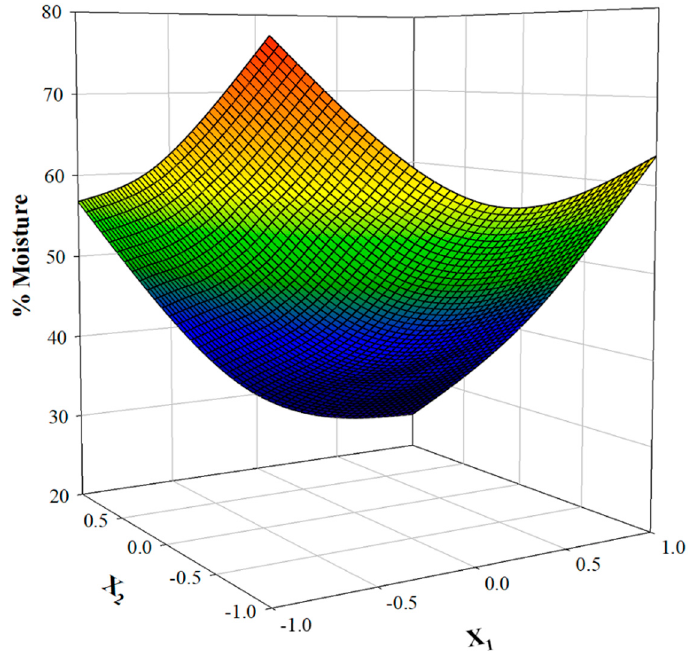
Figure 2. 3D Response surface plot illustrating the effect of the simultaneous variation of T and t on PP moisture levels.